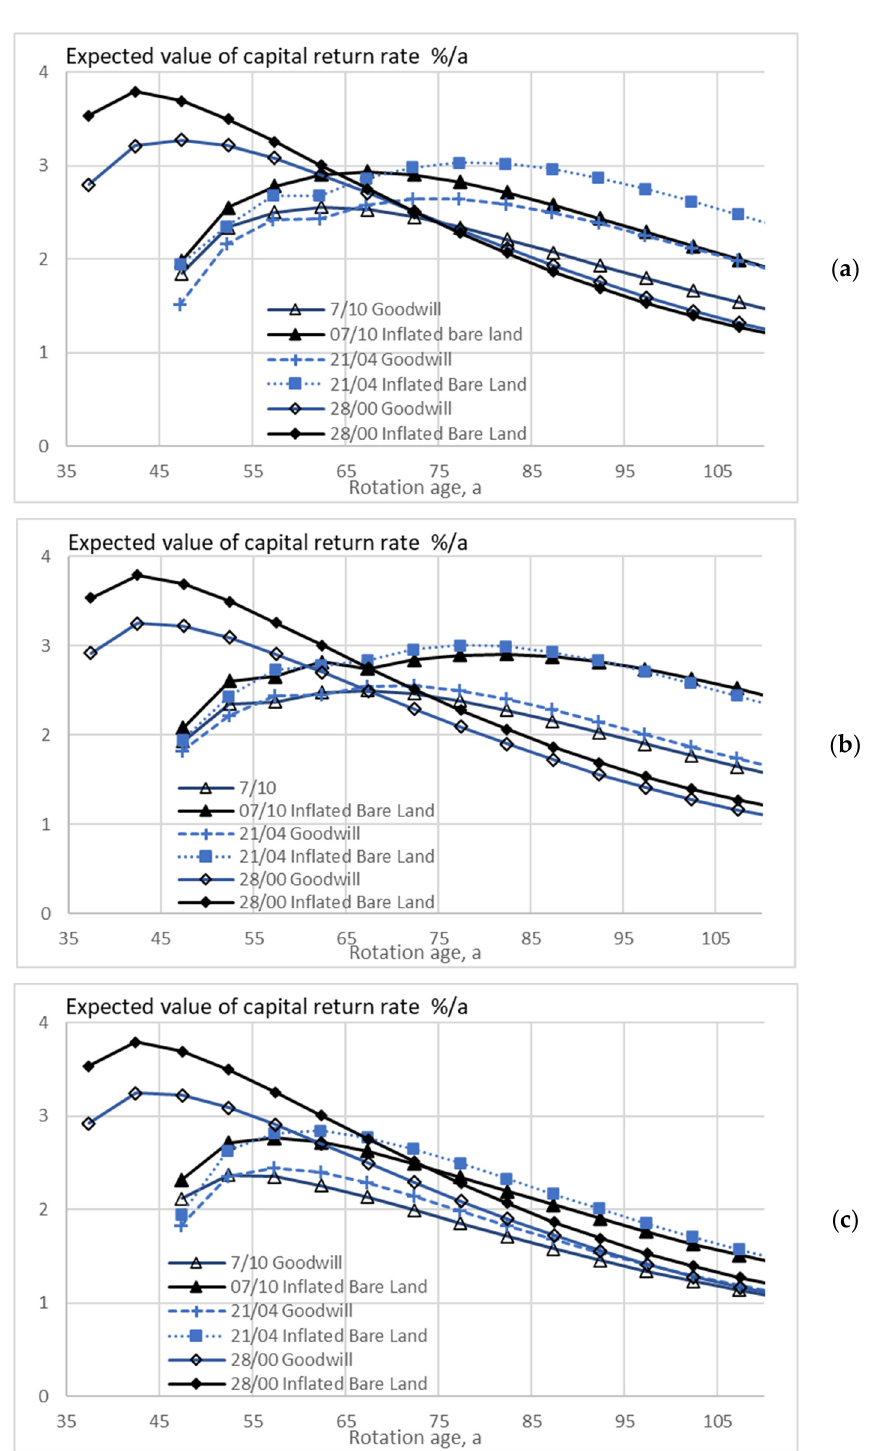
Figure 2. The expected value of capital return rate, as a function of rotation age, when the growth model is applied to three observed wooded stands, without any thinning restriction ( a ), in good- quality trees of at least 238 mm of diameter only removed in thinning ( b ), and without any commercial thinning ( c ). Inflated capitalization is introduced either as proportional goodwill or as inflated bare land value; the numbers in legends identify stands and observation